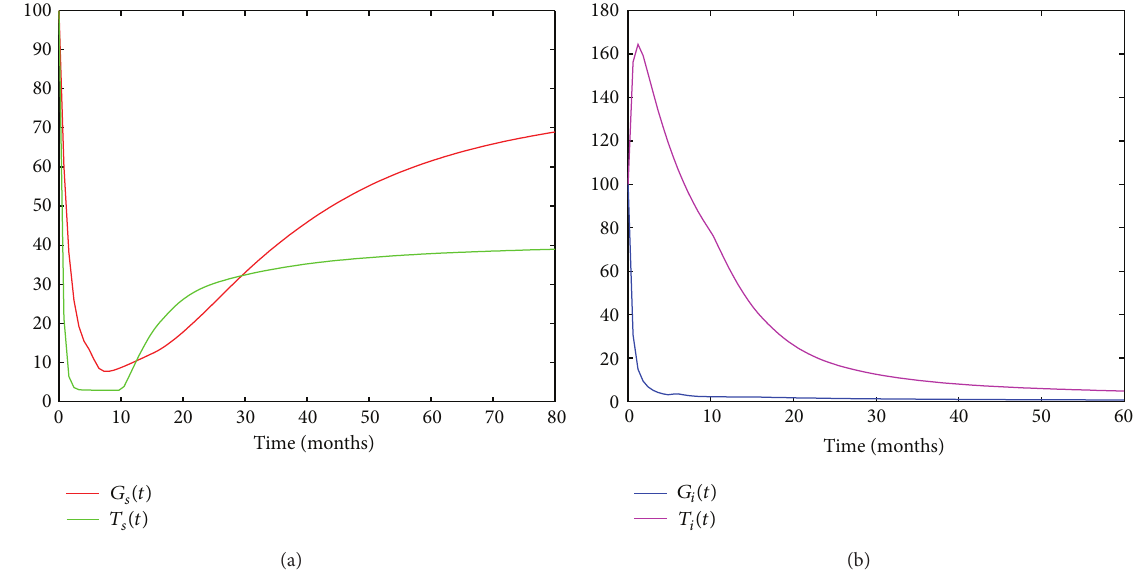
Figure 4: The infection equilibrium 𝐸 ∗ of system (3) is asymptotically stable when 𝜏 = 5 , 𝜔 = 10 , and R 0 > 1 . The initial functions are (100, 10, 100 , and 10)